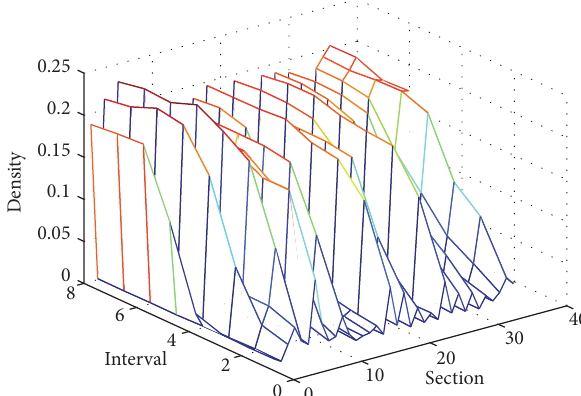
Figure 6: Averaged density before optimization.